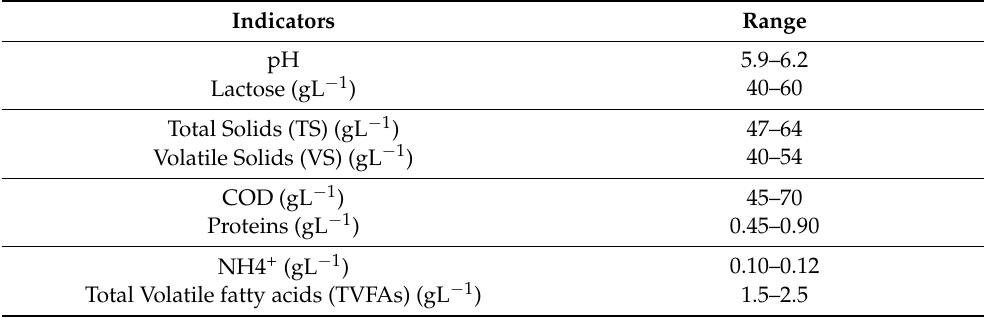
Table 1. Main characteristics of second cheese whey (SCW) used in this